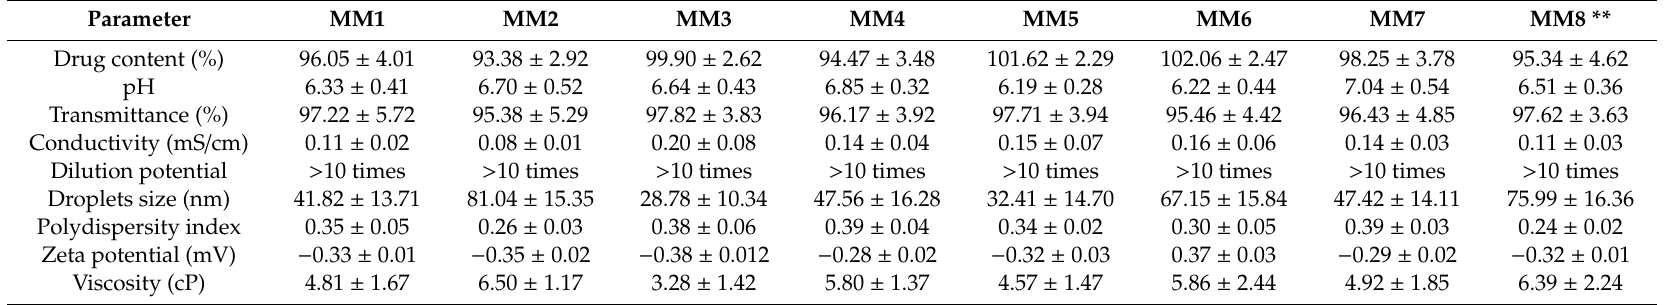
Table 2. Physicochemical characteristics of prepared nanoemulsions